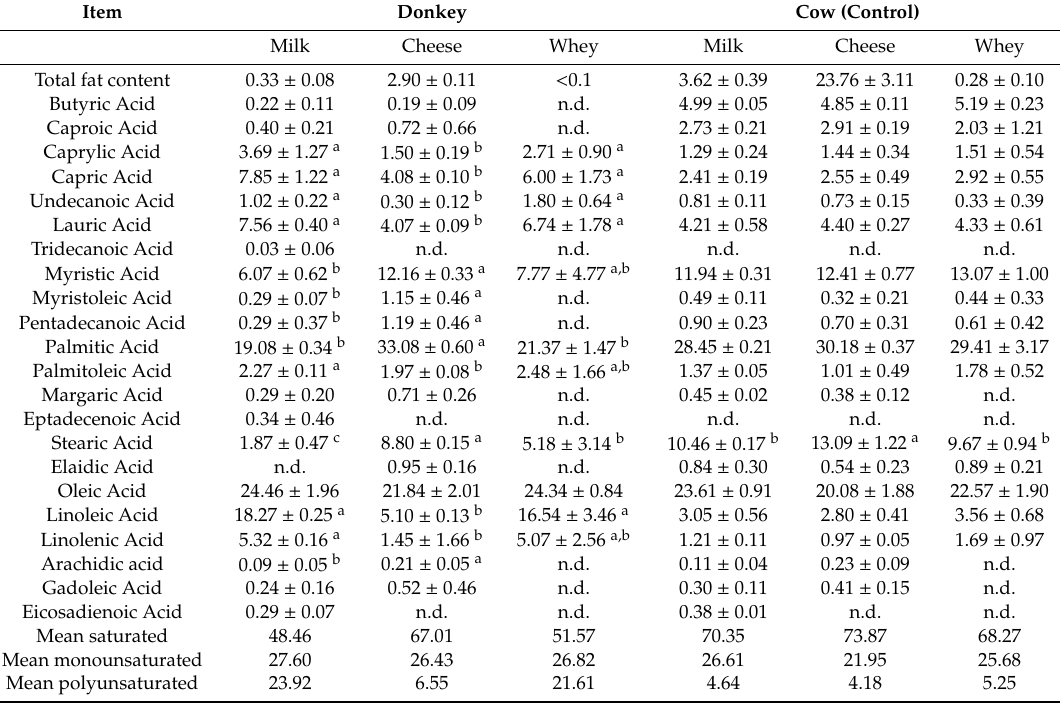
Table 2. Fat content (%) and fatty acid composition (% of total fatty acids) of donkey’s and cow’s milk, cheese and